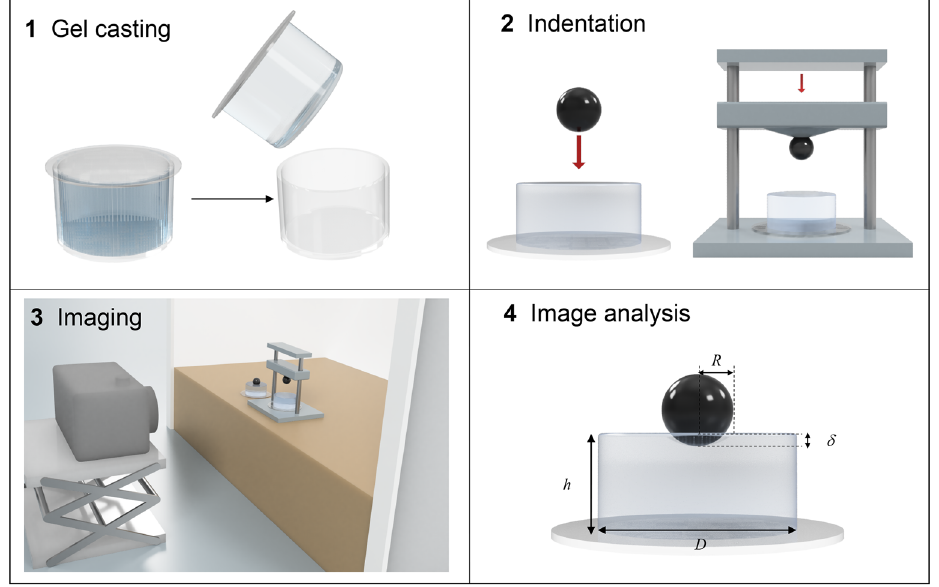
Figure 2. Workflow of the macroindentation process. 1. Preparation of the gel with a cylindrical shape 2. The indenting sphere is put on the hydrogel surface eventually overloaded as shown in the third step 3. The image is captured with a camera 4. And analyzed to determine δ, h, D with a MATLAB